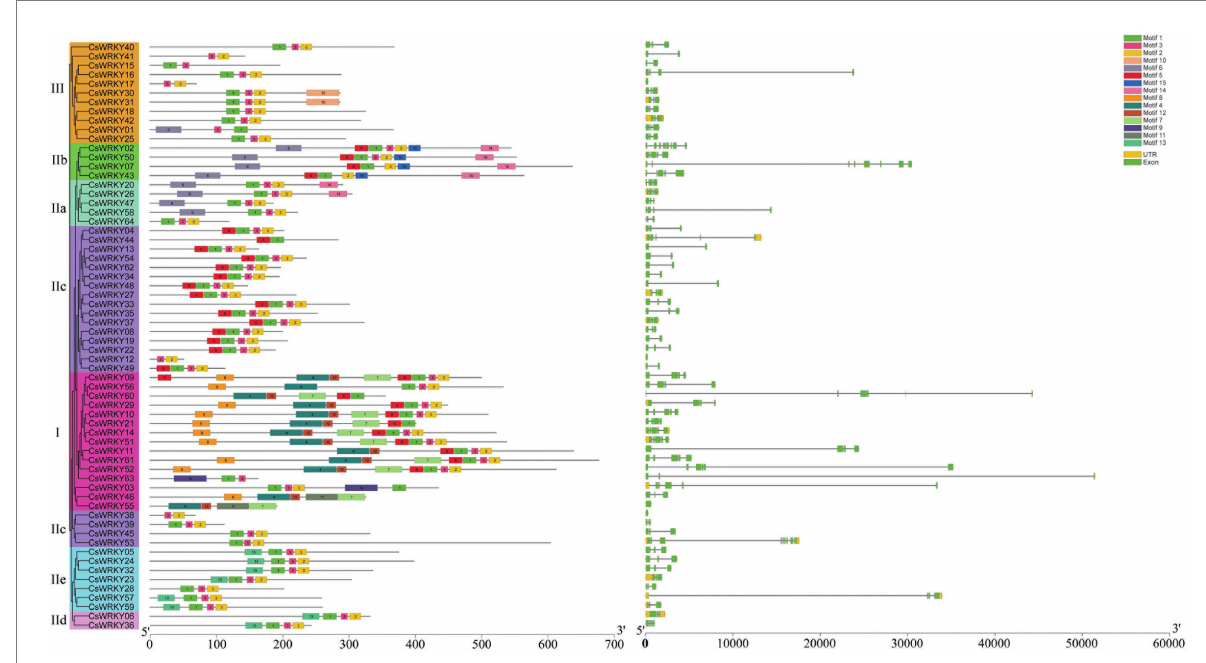
FIGURE 3 Phylogenetic relationships, gene structure, and architecture of conserved protein motifs in WRKY genes from C. sinense